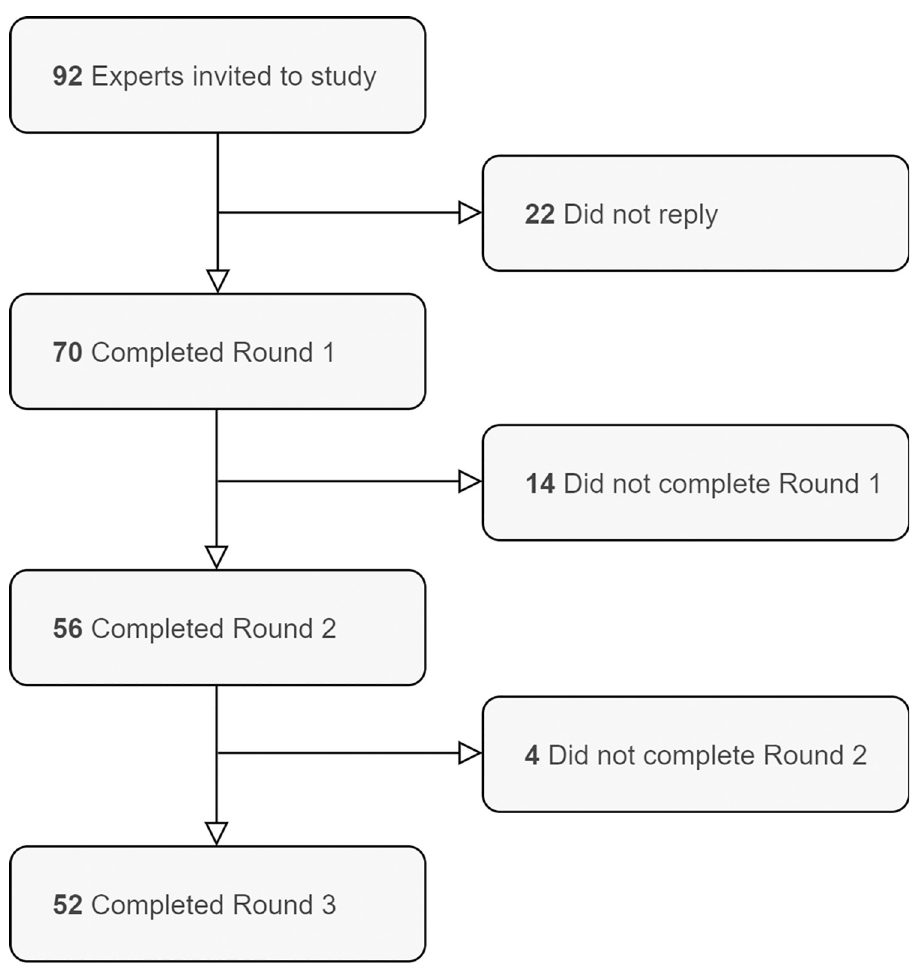
Fig 1. Flowchart of Delphi